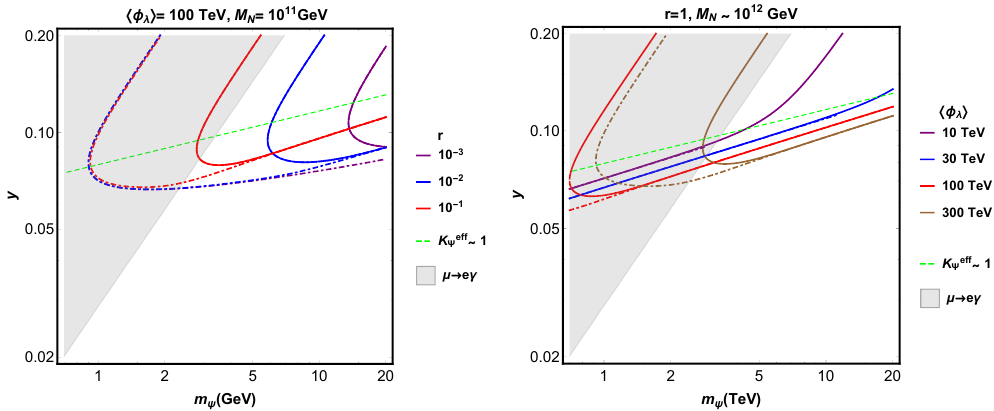
Figure 6 . Solid (dot-dashed) curves are contours in ( m (cid:9) ; y ) plane on which the observed neutrino mass and baryon asymmetry is produced assuming zero (thermal) initial abundance for N , similar to (cid:12)gure 5. In the left panel, we vary r and keep M N and the results with varying (cid:8) (cid:21) while keeping M N and r (cid:12)xed. The gray shaded region is constrained h i by (cid:22) e(cid:13) !